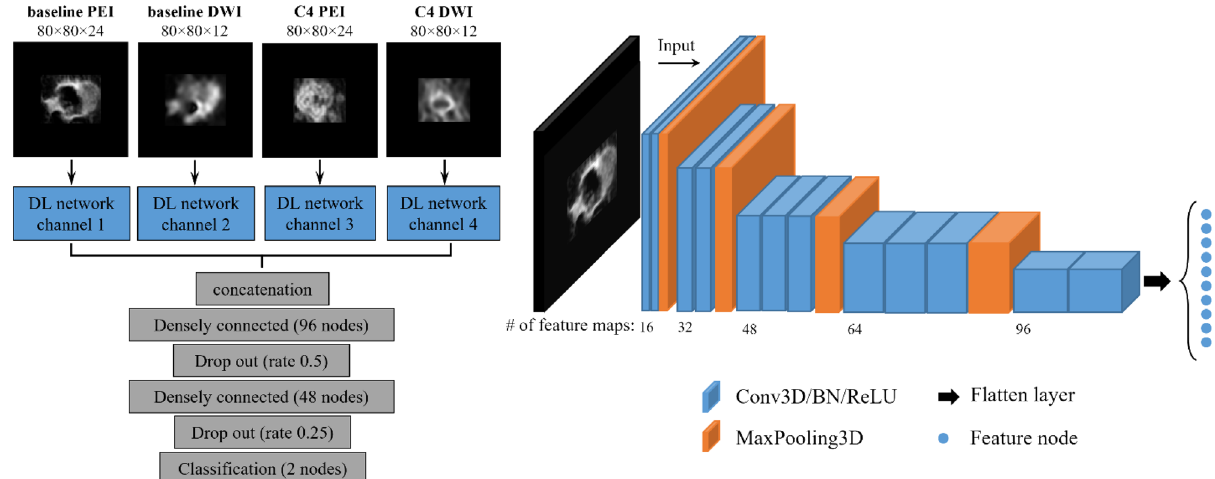
Figure 4. The deep learning network. The framework of the feature extraction module, shown at left, consisted of four input channels corresponding to baseline positive enhancement integral (PEI), baseline diffusion- weighted imaging (DWI), PEI acquired after 4 cycles of doxorubicin/cyclophosphamide treatment (C4 PEI), and DWI acquired after 4 cycles of doxorubicin/cyclophosphamide treatment (C4 DWI). The detailed structure of the feature extraction module of one channel is shown at right. The extracted features of the four channels were concatenated and used for breast pathologic complete response prediction. Two dropout layers were added after the densely connected layers to prevent overfitting of the model. Conv3D: 3D convolutional layer, BN: batch normalization, ReLU: rectified linear unit, MaxPooling3D: 3D max pooling